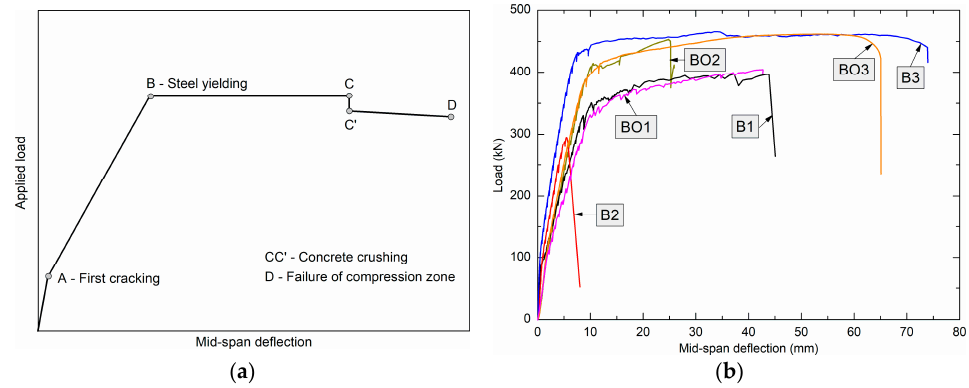
Figure 4. Load-deflection curves for beams: ( a ) idealized response; ( b ) experimental response.